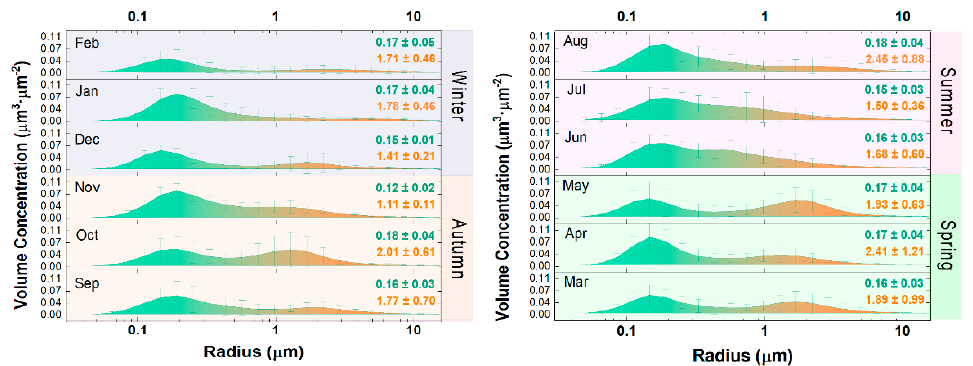
Figure 3. Monthly variation in columnar aerosol volume size distribution over the study period. The average and standard deviation of effective radius of fine- and coarse-mode aerosols are marked in green and orange, respectively, in each panel.